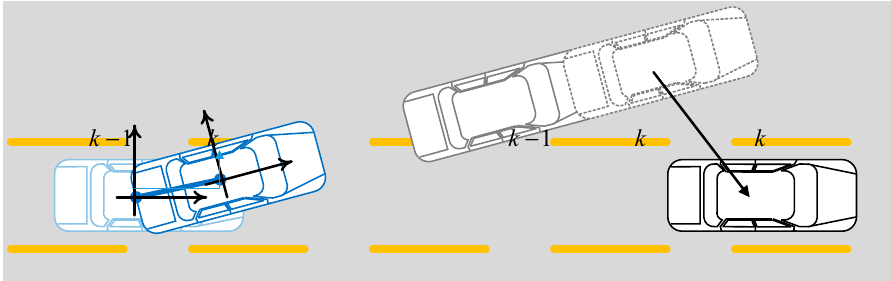
Figure 5. Coordinate change of predictions (vehicles with gray line are vehicles that detected and predicted at time k-1 ).